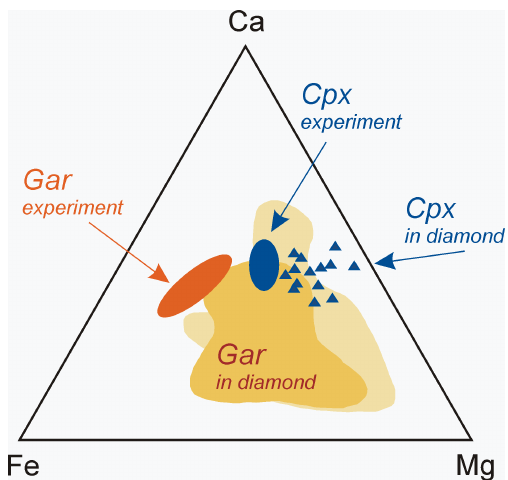
Figure 9. Chemical composition of synthetic garnet (oval-shape field “Gar experiment”) and clinopyroxene (oval-shape field “Cpx experiment”) of this study compared to silicate inclusions of eclogitic paragenesis in natural diamonds: grossular–pyrope– almandine garnet (“Gar in diamond”) and omphacite clinopyroxene (triangles). Data on natural samples are from Sobolev (1977), Harris and Gurney (1979), Davis et al. (2003), and Liu et al.